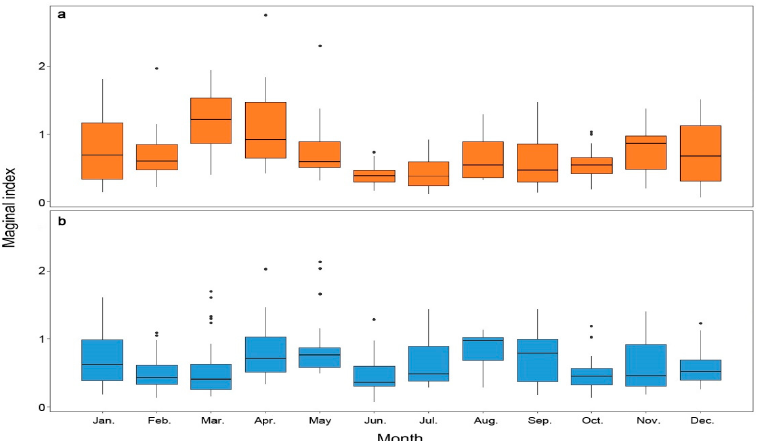
Figure 7. Monthly variation of the marginal index (mean and standard deviation) of the vertebral centra in ( a ) female and ( b ) male specimens of Okamejei kenojei collected from the West Sea of South